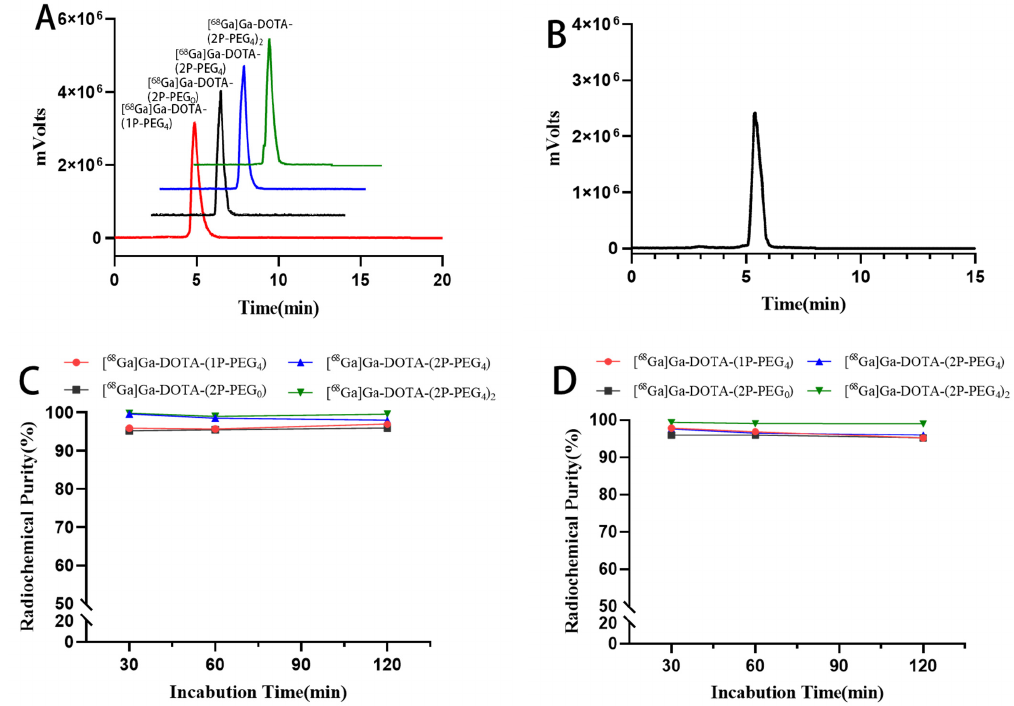
Figure 1. The radiochemical purity of four 68 Ga-labeled ligands detected by HPLC. ( A ): HPLC results of 68 Ga-labelled DOTA-(1P-PEG 4 ), DOTA-(2P-PEG 4 ), DOTA-(2P-PEG 0 ), and DOTA-(2P-PEG 4 ) 2 ; ( B ): HPLC results of [ 177 Lu]Lu-DOTA-(2P-PEG 4 ) 2 ; ( C , D ): radiochemical purity of [ 68 Ga]Ga-DOTA- (1P-PEG 4 ), [ 68 Ga]Ga-DOTA-(2P-PEG 4 ), [ 68 Ga]Ga-DOTA-(2P-PEG 0 ), and [ 68 Ga]Ga-DOTA-(2P-PEG 4 ) 2 incubated in PBS/FBS for 2 h at 37 °C.